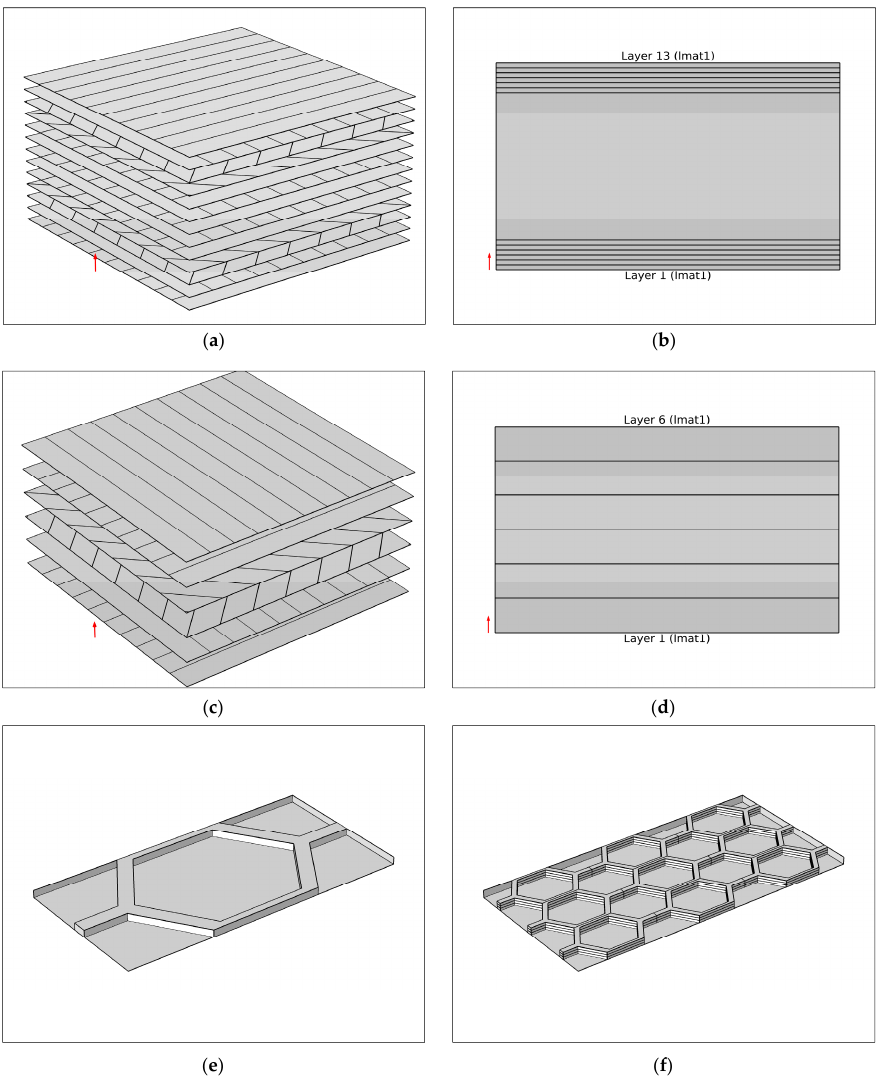
Figure 3. ( a ) The quasi-isotropic laminates with a honeycomb layer (plies with 0°, 90°, +45°, − 45°, 0°, 90°; one layer of honeycomb; and plies with 90°, 0°, − 45, +45, 90°, 0°), ( b ) quasi-isotropic laminates with honeycomb in the middle, ( c ) quasi-isotropic laminates without honeycomb (0°, 90°, +45°, − 45°, 0°, 90°), ( d ) quasi-isotropic laminates without honeycomb, ( e ) a sample honeycomb unit cell, and ( f ) a sample honeycomb layer.